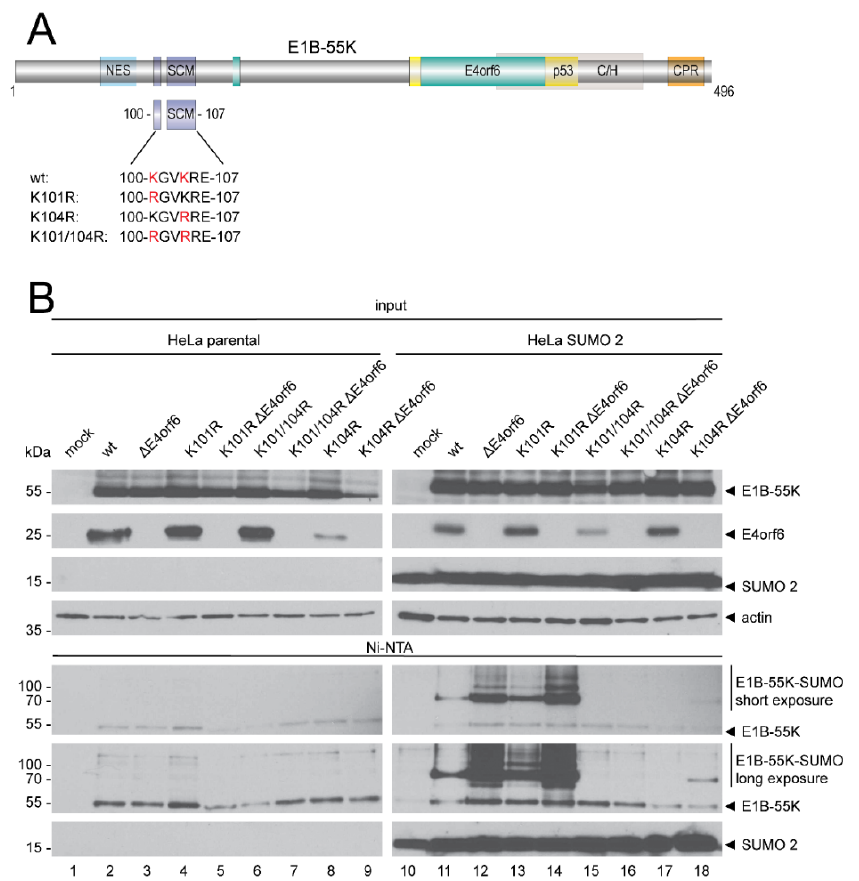
Figure 1. E4orf6 regulates E1B-55K SUMOylation and inhibits SUMO attachment. ( A ) Schematic overview of the HAdV-C5 E1B-55K protein. The HAdV-C5 SUMO conjugation mutants carry lysine (K) to arginine (R) substitutions at the SUMO conjugation sites (SCS) K101, K104, and K101 plus K104, respectively. NES, nuclear export signal. The turquoise E4orf6- and the yellow p53-boxes indicate the respective essential binding regions of these proteins to E1B-55K. C/H, conserved histidine (H) and cysteine (C)-rich zinc finger binding domain. CPR, C-terminal phosphorylation region. Amino acid positions are indicated. ( B ) Parental HeLa cells and HeLa cells that constitutively express His-tagged SUMO 2 were mock infected or infected with HAdV-C5 wt and indicated mutants at an MOI of 20. Cells were harvested at 24 h p.i. and His-SUMO conjugates were Ni-NTA purified. Precipitates and total cell lysates were separated according to their molecular weight by SDS-PAGE and visualized by Western blotting. For specific protein detection, mAb 2A6 (E1B-55K), mAb RSA3 (E4orf6), mAb 6×His (SUMO 1/2), and mAb AC-15 (actin) were used. Molecular weights in kDa are indicated on the left, while corresponding proteins are labeled on the right. Images represent the results of >3 repeated experiments.